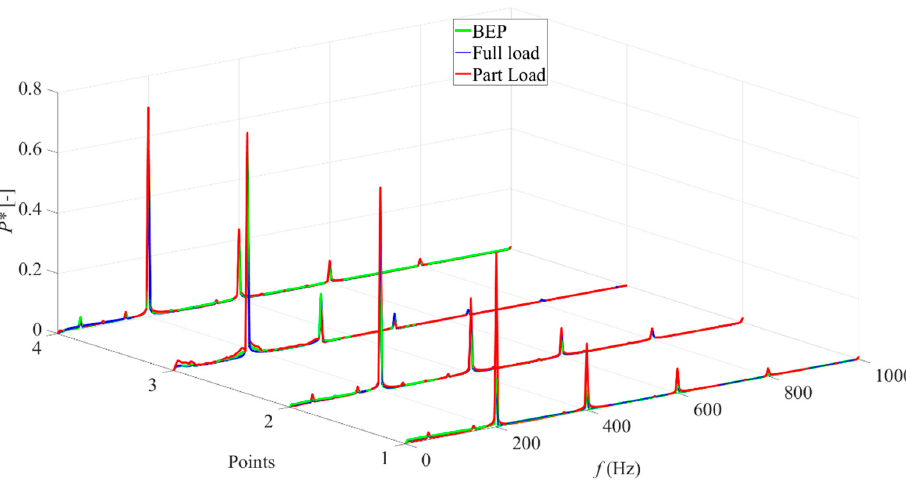
Figure 15. Frequency spectrum of pressure time signals at vaneless space.